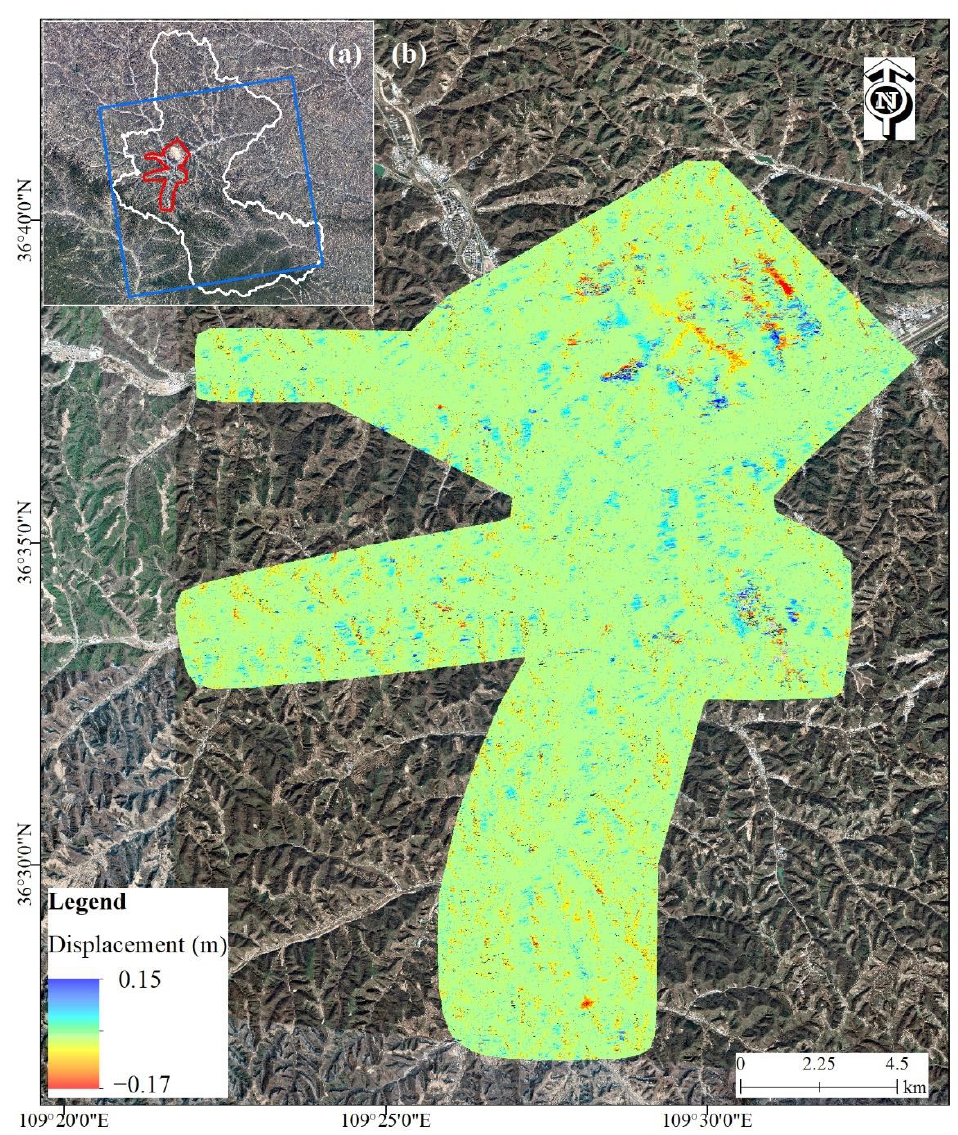
Figure 5. Area covered by two ascending SAR images from ALOS-2 (blue rectangle) in ( a ), and image of the LOS displacement of the study area (red polygon) using DInSAR technology in ( b ).